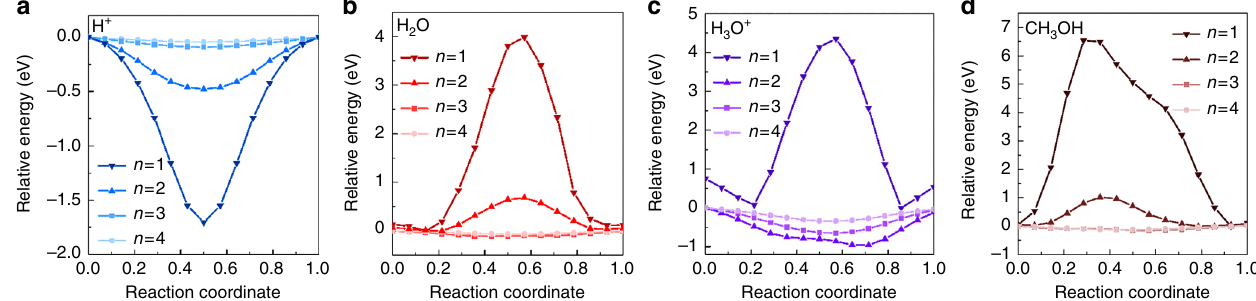
Fig. 2 Penetration energy barriers of different species across graphyne in a vacuum. a proton b water c hydronium ion d methanol